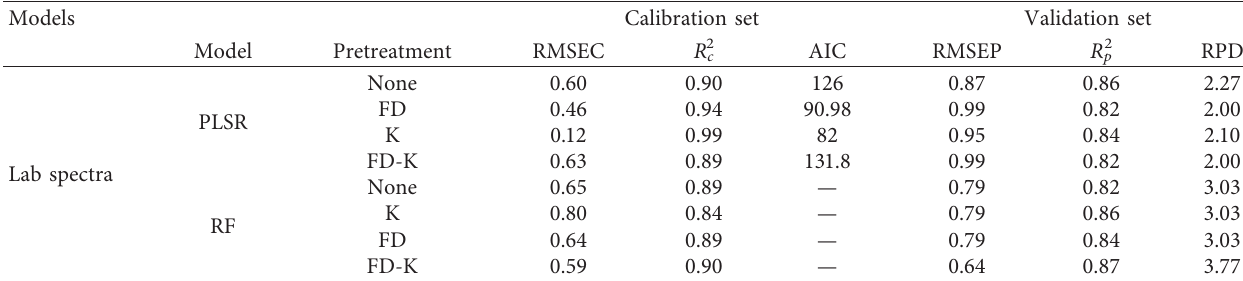
Table 3: Performance of all RF regression and PLSR models in the calibration and validation laboratory datasets (RMSEC and RMSEP in g 100g − 1 ).